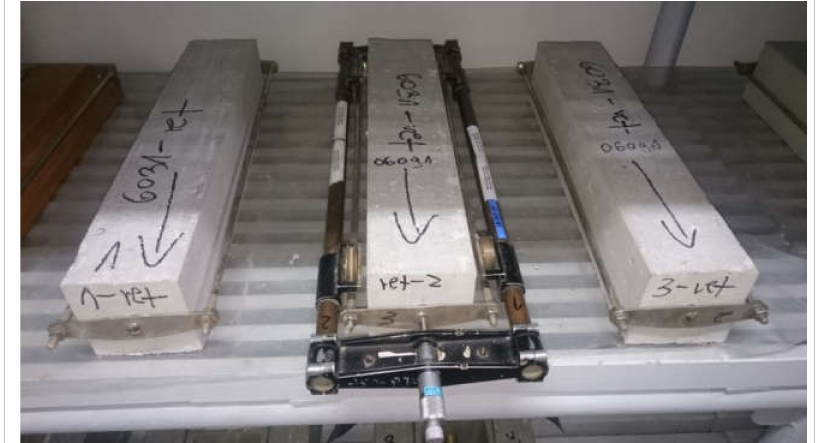
Figure 4. Measure of sample during shrinkage